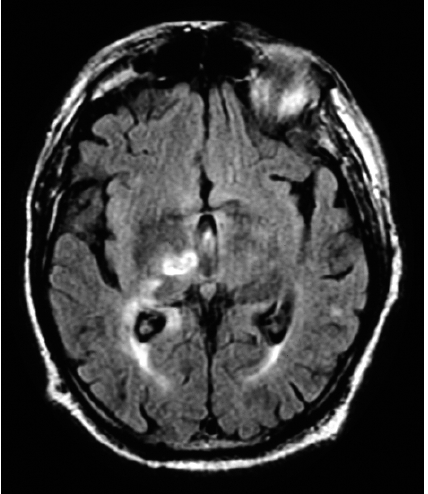
Fig. 1. Brain MRI axial FLAIRslices performed 1 month after stroke disclosing an infarction in the median region of the right thalamus as well as some small hyperintense lesions around the anterior and posterior lateral